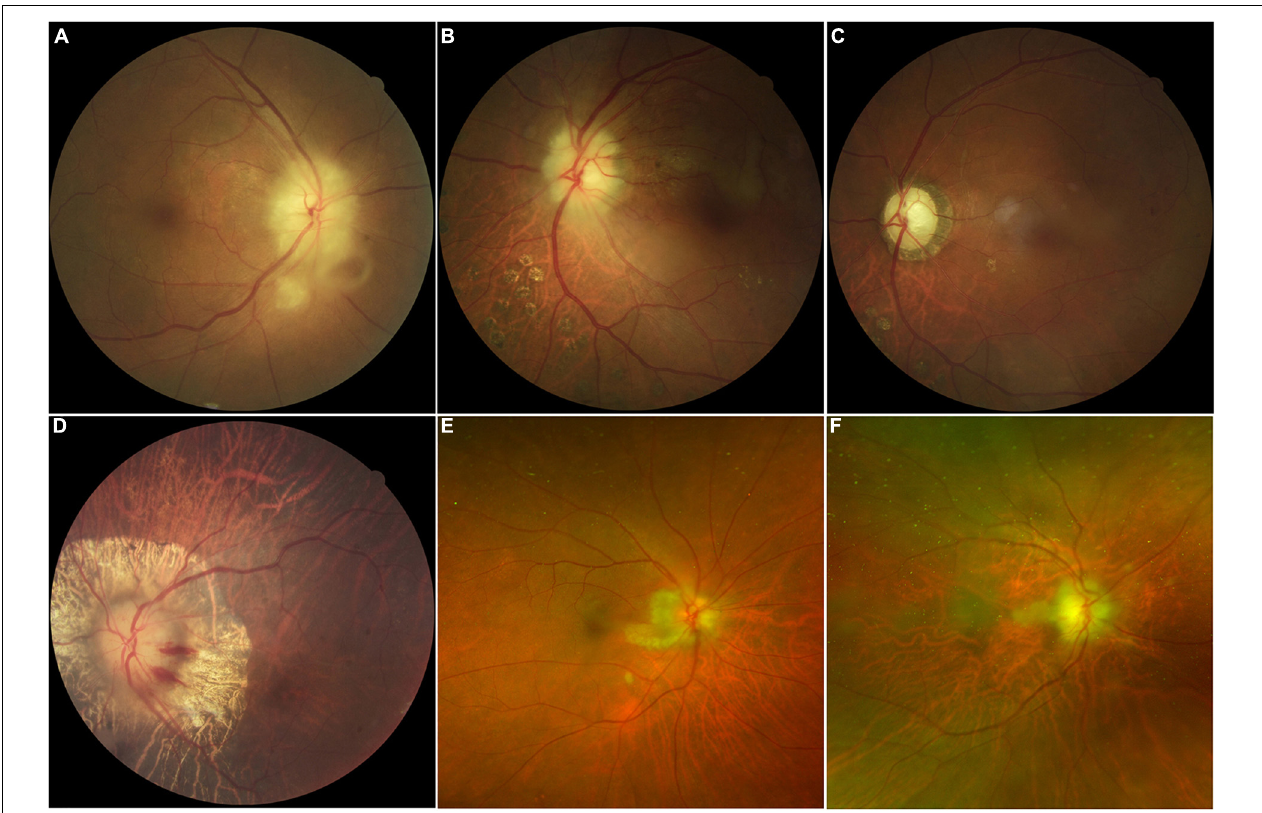
FIGURE 1 | Color fundus photographs in patients with giant cell arteritis showing chalky-white swollen discs (A,B,D) with retina exudate and cotton-wool spots (A) , late-stage optic atrophy and cupping (C) , peripapillary hemorrhage with atrophy (D) , and cilioretinal artery occlusion (B,C,E,F) are the same